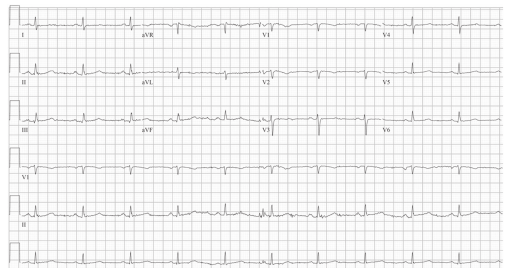
Figure 5: ECG after discharge shows sinus rhythm and no